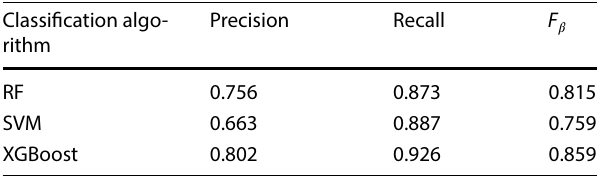
Table 5 Comparison of results of different classification algorithms